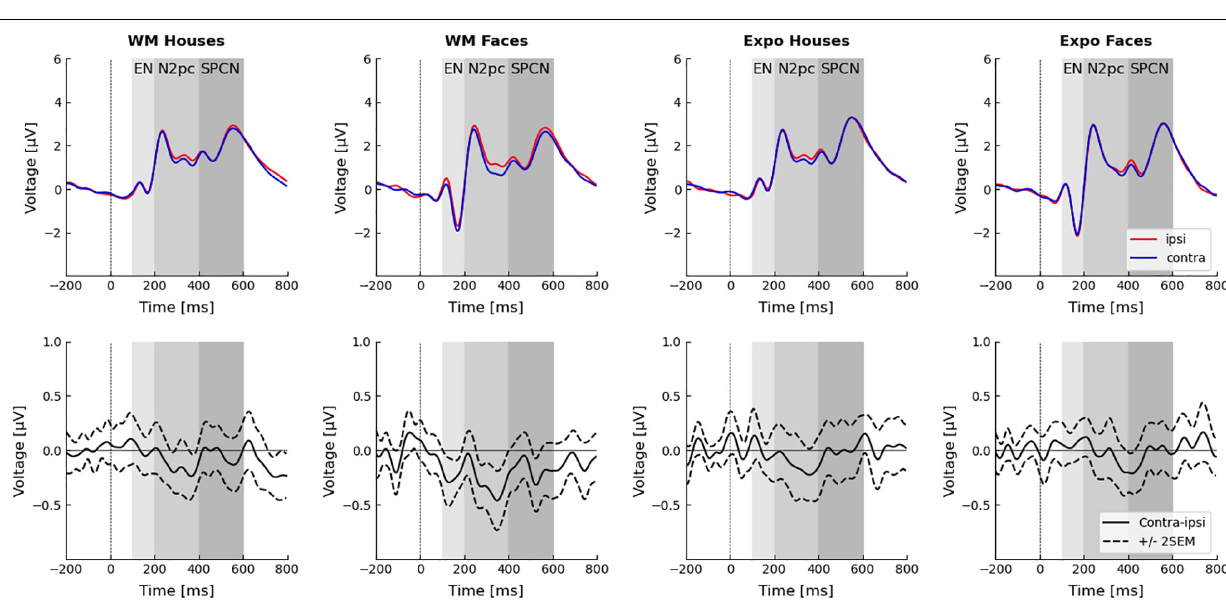
FIGURE 3 | Event related potentials in the dot-probe task. Electrodes P7/P8 were chosen for the analysis. Waveforms recorded ipsi- and contra-laterally with respect to the seen or memorized stimulus are presented in the top row. Difference waveforms (i.e., contra–ipsi-lateral side) are presented in the bottom-row. Time windows of the three analyzed components–the early negativity (EN; 100–200 ms), N2pc (200–400 ms), and SPCN (400–600 ms)–are